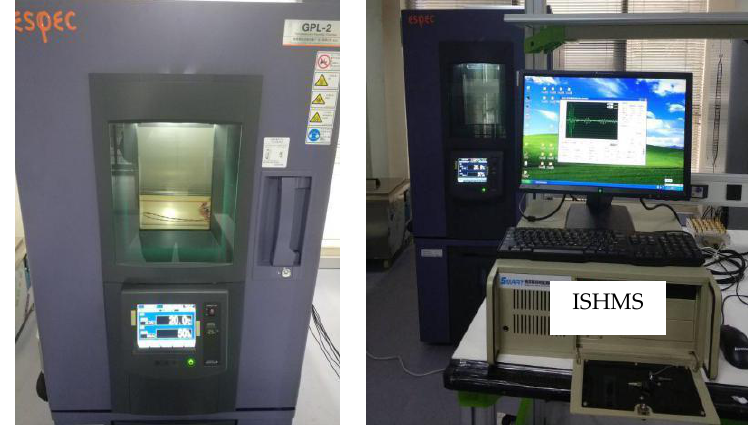
Figure 3. Schematic of experimental setup for temperature testing.